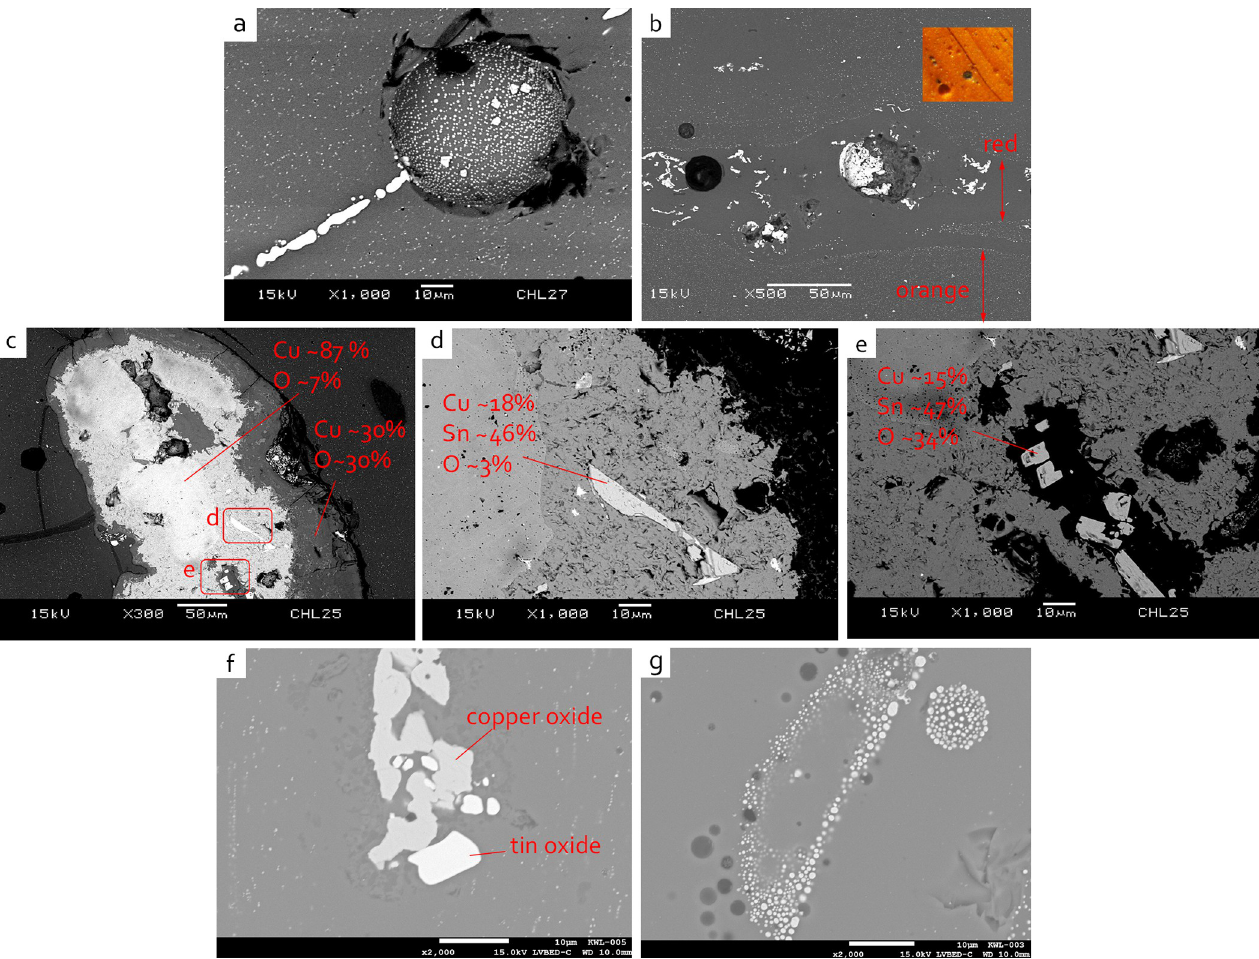
Fig 5. BSE image showing the microstructure of orange glass, in which (a) copper-bearing crystals of micro size distribute linearly over the glass matrix or fill within round voids (JXL27), (b) large copper oxide crystals are found in the red striae, while the particles of sub-micron size spread over the orange matrix (JXL24), (c)-(e) oxidised bronze prill was observed (JXL25, wt%), (f) a cluster of copper oxide and tin oxide suggesting decomposition from bronze (KWL005), and (g) large metallic copper crystals are confirmed by EDS (KWL003).